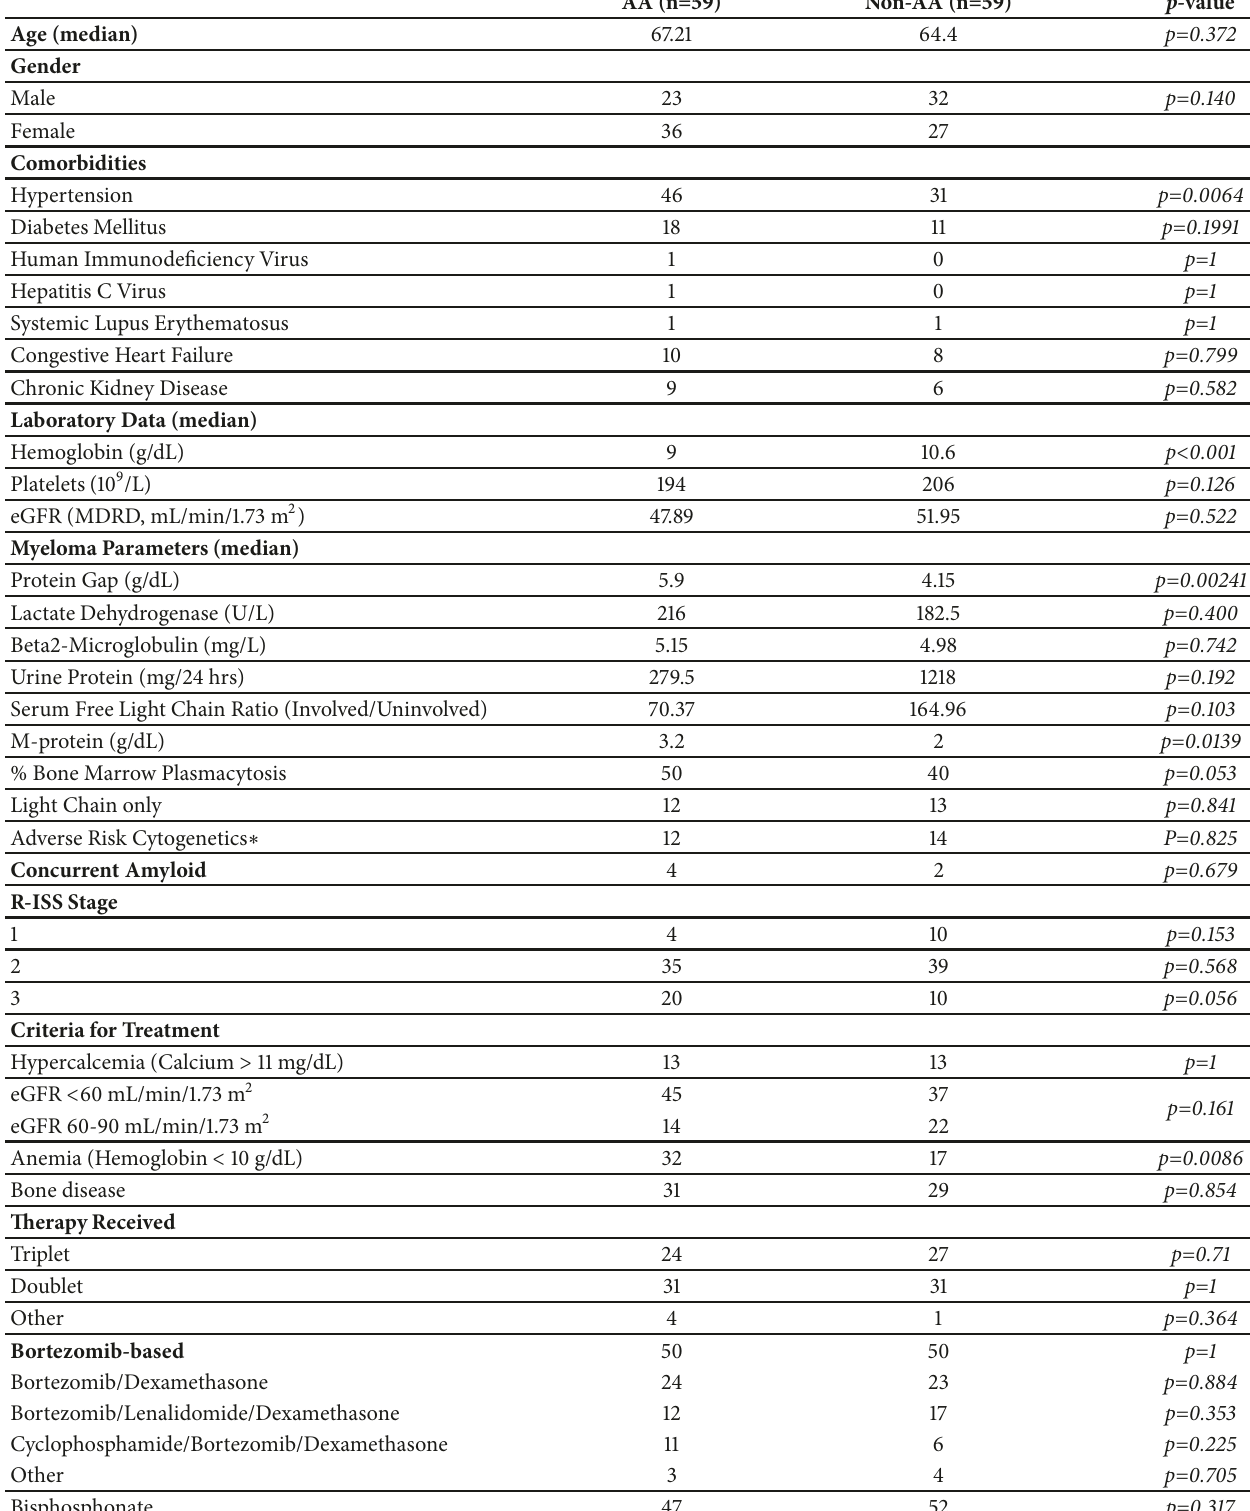
Table 2: Baseline data and patient